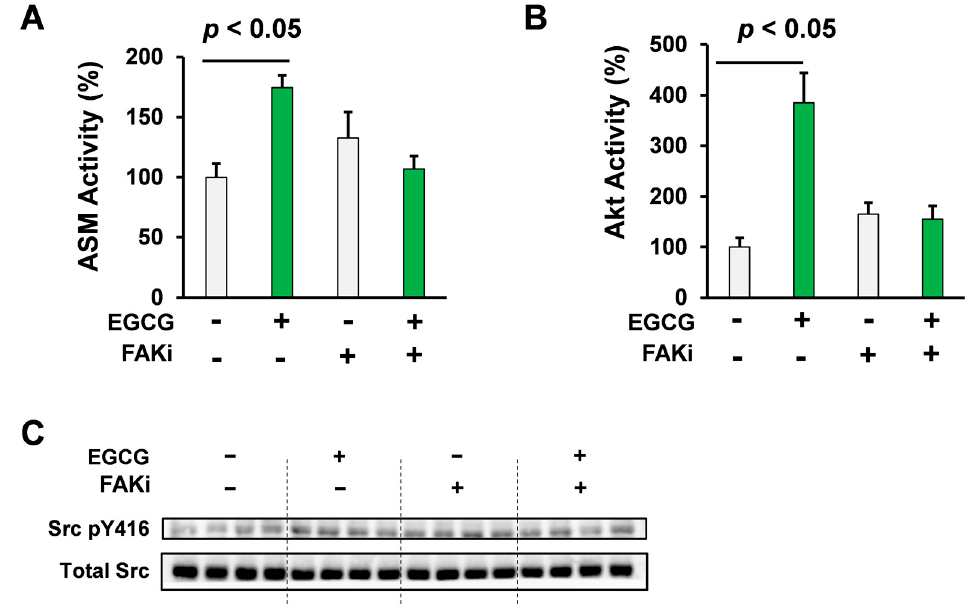
Figure 3. Pharmacological inhibition of FAK attenuated the Akt / ASM axis elicited by EGCG. ( A ) U266 human multiple myeloma cells were treated with EGCG (10 µ M) and PF-573228 (1 µ M; from 1 h before EGCG treatment) for 3 h ( n = 3). ( B ) U266 human multiple myeloma cells were treated with EGCG (10 µ M) and PF-573228 (1 µ M; from 1 h before EGCG treatment). Akt activity was evaluated using the K-LISA kit ( n = 3). ( C ) U266 human multiple myeloma cells were treated with EGCG (10 µ M) and PF-573228 (1 µ M; 1 h before EGCG treatment) for 30 min. Src phosphorylation levels were evaluated using western blotting ( n = 4). Data are presented as means ± SEM.